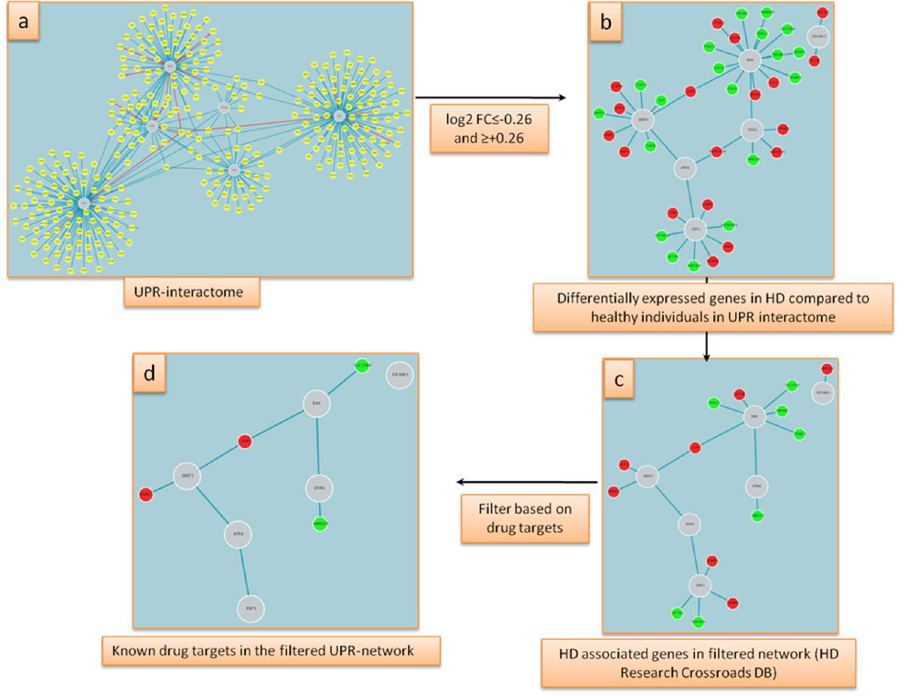
Figure 5. Sequential filtering of UPR interactome. ( a ) Initial UPR network; ( b ) Network after filtering by differential expression in human HD caudate nucleus samples using the criteria log2 fold change ≥ + 0.25 and ≤− 0.25; ( c ) Network of dysregulated components which have been indicated as potential therapeutic targets for HD; ( d ) Final network obtained after filtering using protein-drug target information (DrugBank). Red and green nodes indicate up and down regulated genes, respectively, and large grey nodes represent query